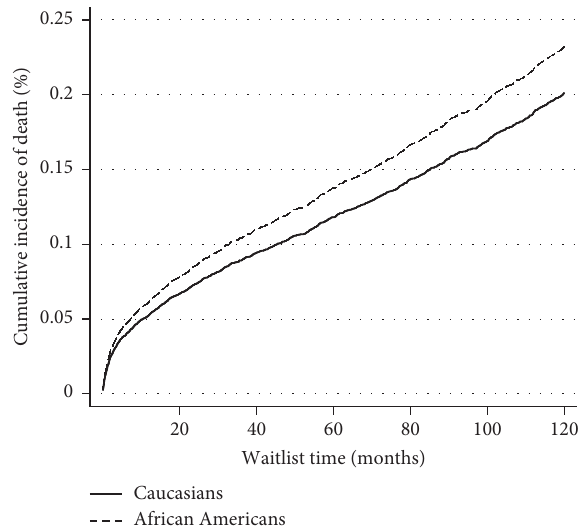
Figure 3: Competing risk analysis for cumulative incidence of death with retransplantation as competing